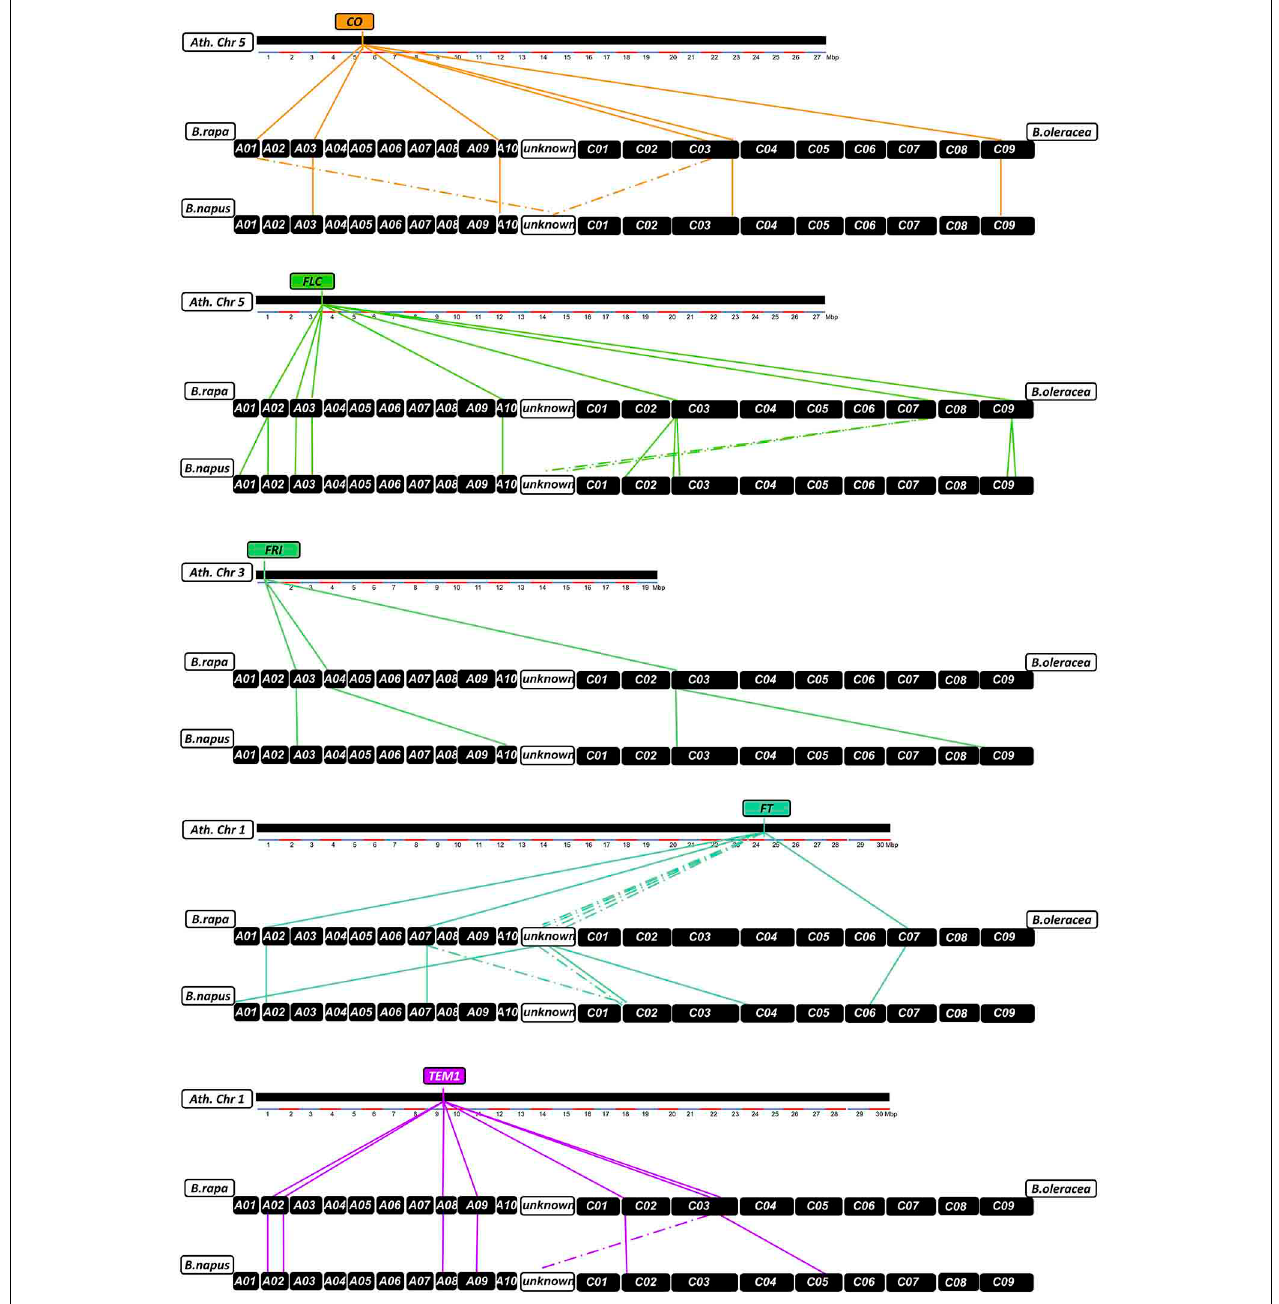
FIGURE 6 | Relationships between homologs from Arabidopsis thaliana , Brassicarapa , Brassicaoleracea ,and Brassicanapus forthefloweringtime regulatory genes CO , FLC, FRI, FT, and TEM1 . Chromosomes are shown as